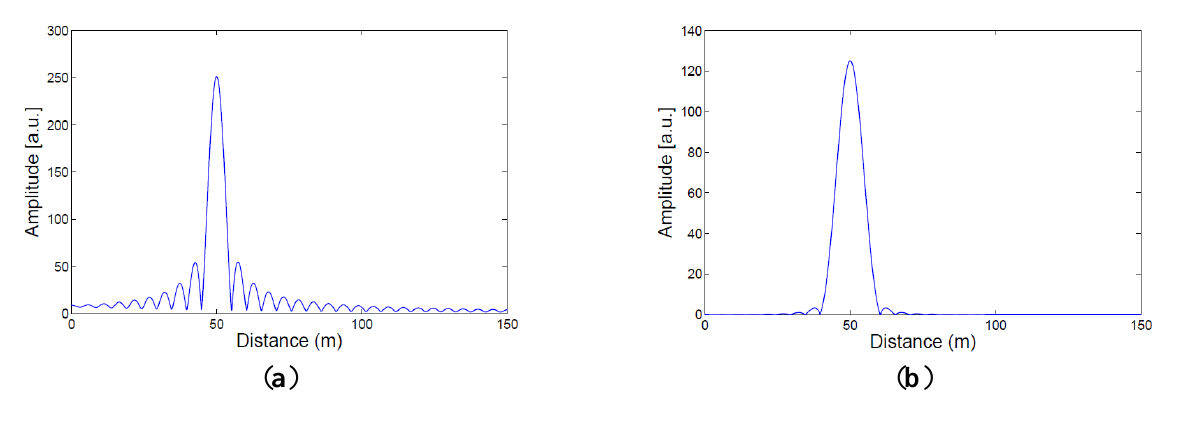
Figure 11. The effects of windowing in DFT. Given the same interference signal  I , a Hann window can effectively suppress the side lobes of a Fourier peak. ( a ) DFT spectrum of  I with a rectangular window. ( b ) DFT spectrum of  I with a Hann